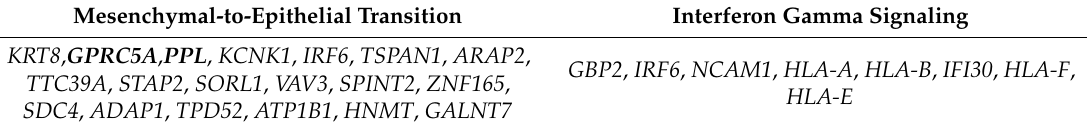
Table 5. Tumors with upregulated ABAT transcripts overexpress select genes in enriched biological pathways.